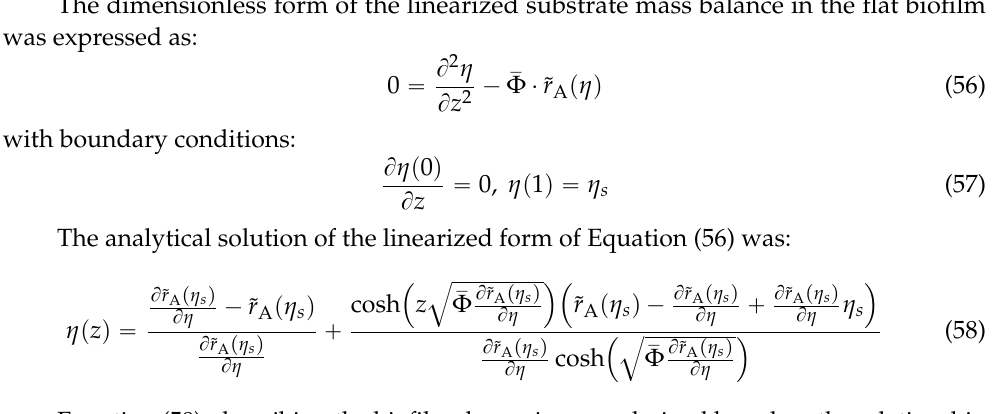
Figure 2. Relative difference between average biomass growth rate calculated for spherical and flat biofilm.